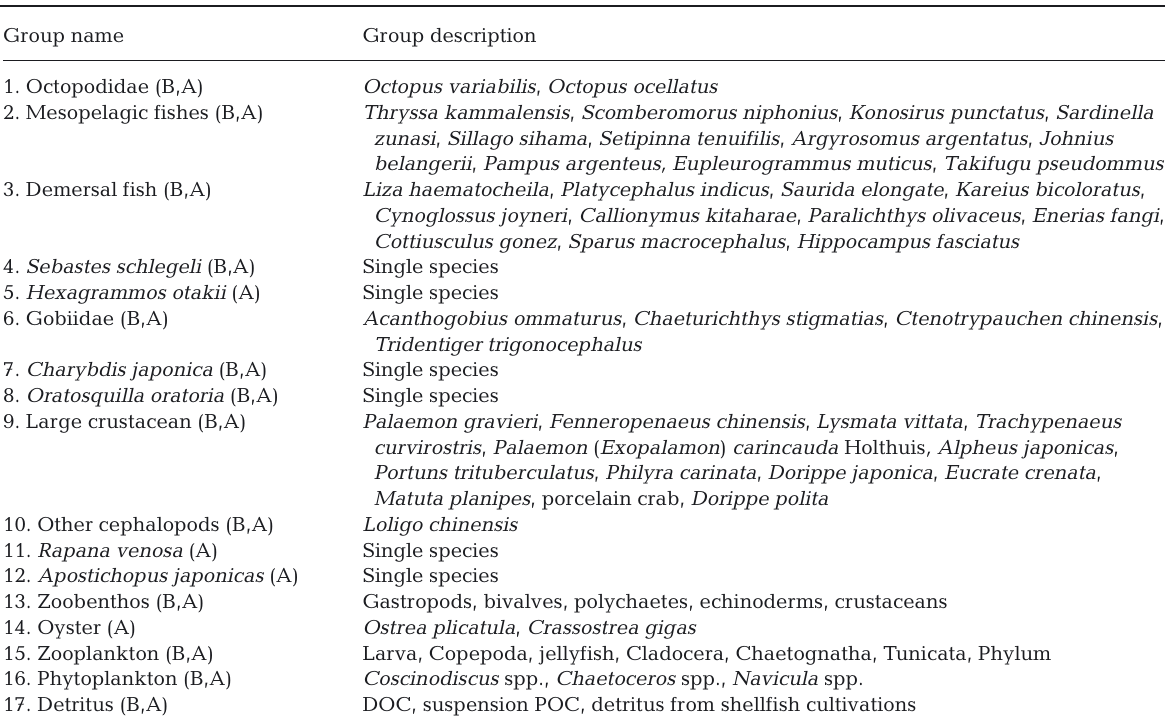
Table 1. Functional groups included in the trophic model before (B) and after (A) artificial reef deployment in Laizhou Bay, Bohai Sea, PR China in 2010 and 2016. DOC: dissolved organic carbon; POC: particulate organic